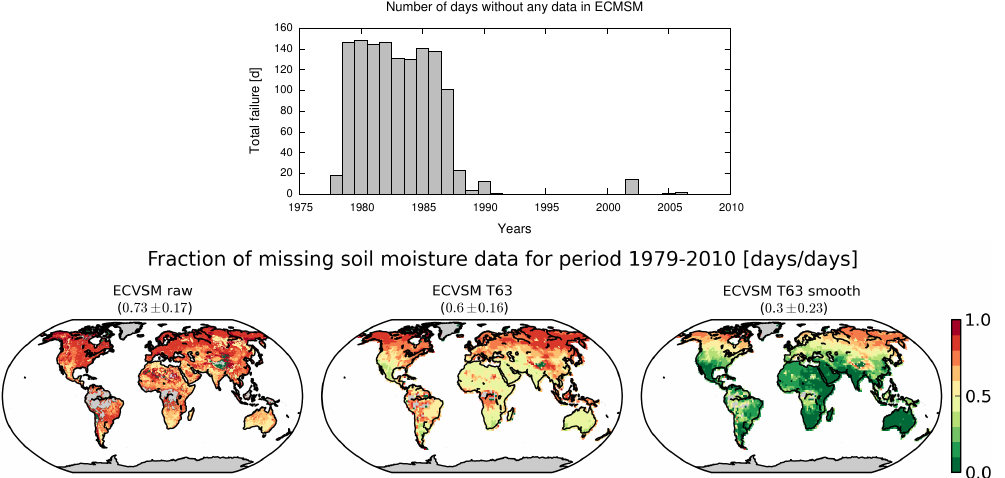
Fig. 2. Number of days per year without any soil moisture observations globally in ECVSM (top panel); fractional coverage of missing data for ECMSM in different pre-processing steps: raw: data at original spatial and temporal resolution, T63: data remapped to T63 grid, smooth: time series smoothed with 5 day running average kernel. Numbers in the figure titles indicate global mean and stdv (bottom)